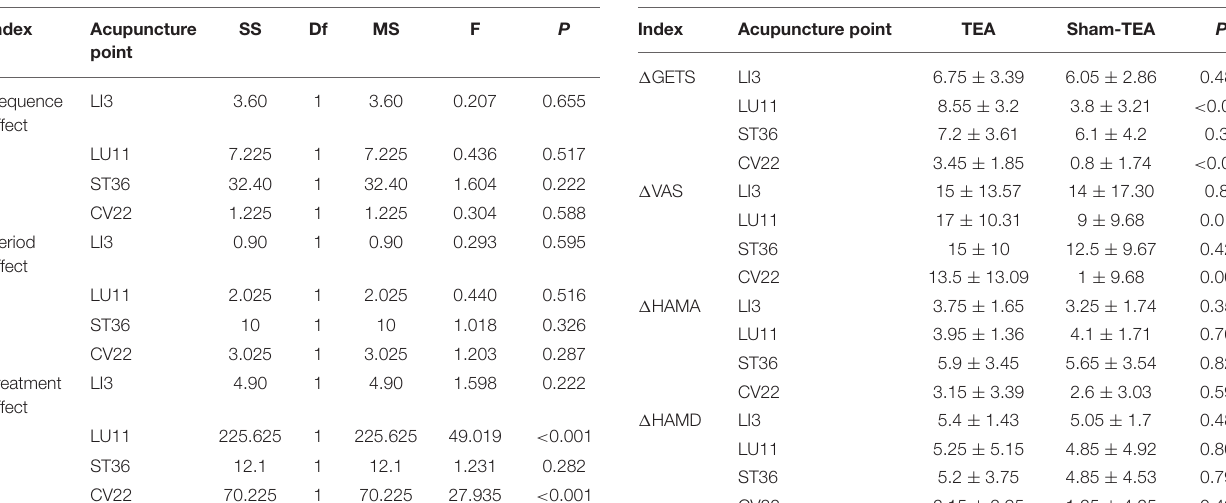
TABLE 3 | Sequence, period, and treatment effects on 1 GETS. TABLE 4 | Differences between TEA and sham-TEA.